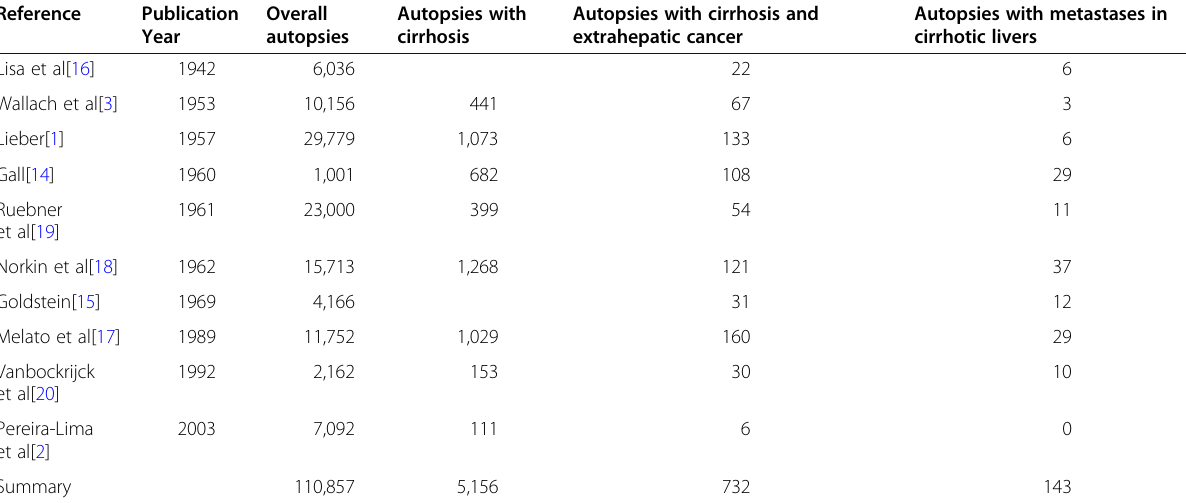
Table 3 Previous studies of metastases in patients with cirrhotic